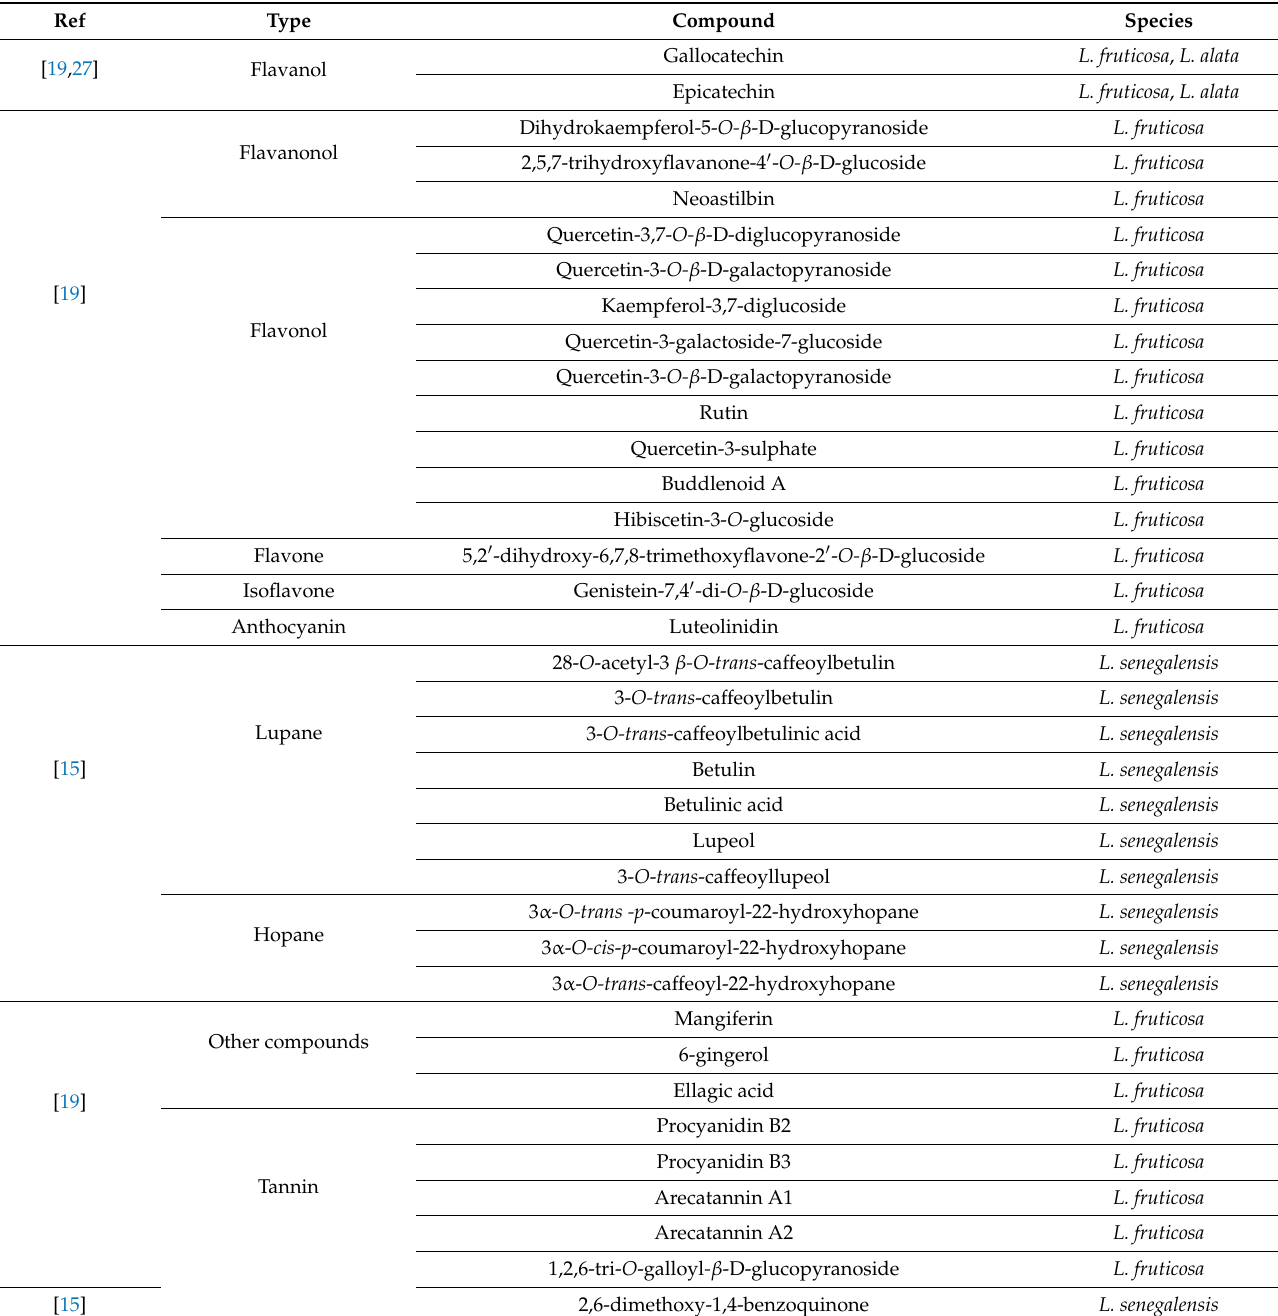
Table 2. Phytochemical compounds of Lepisanthes